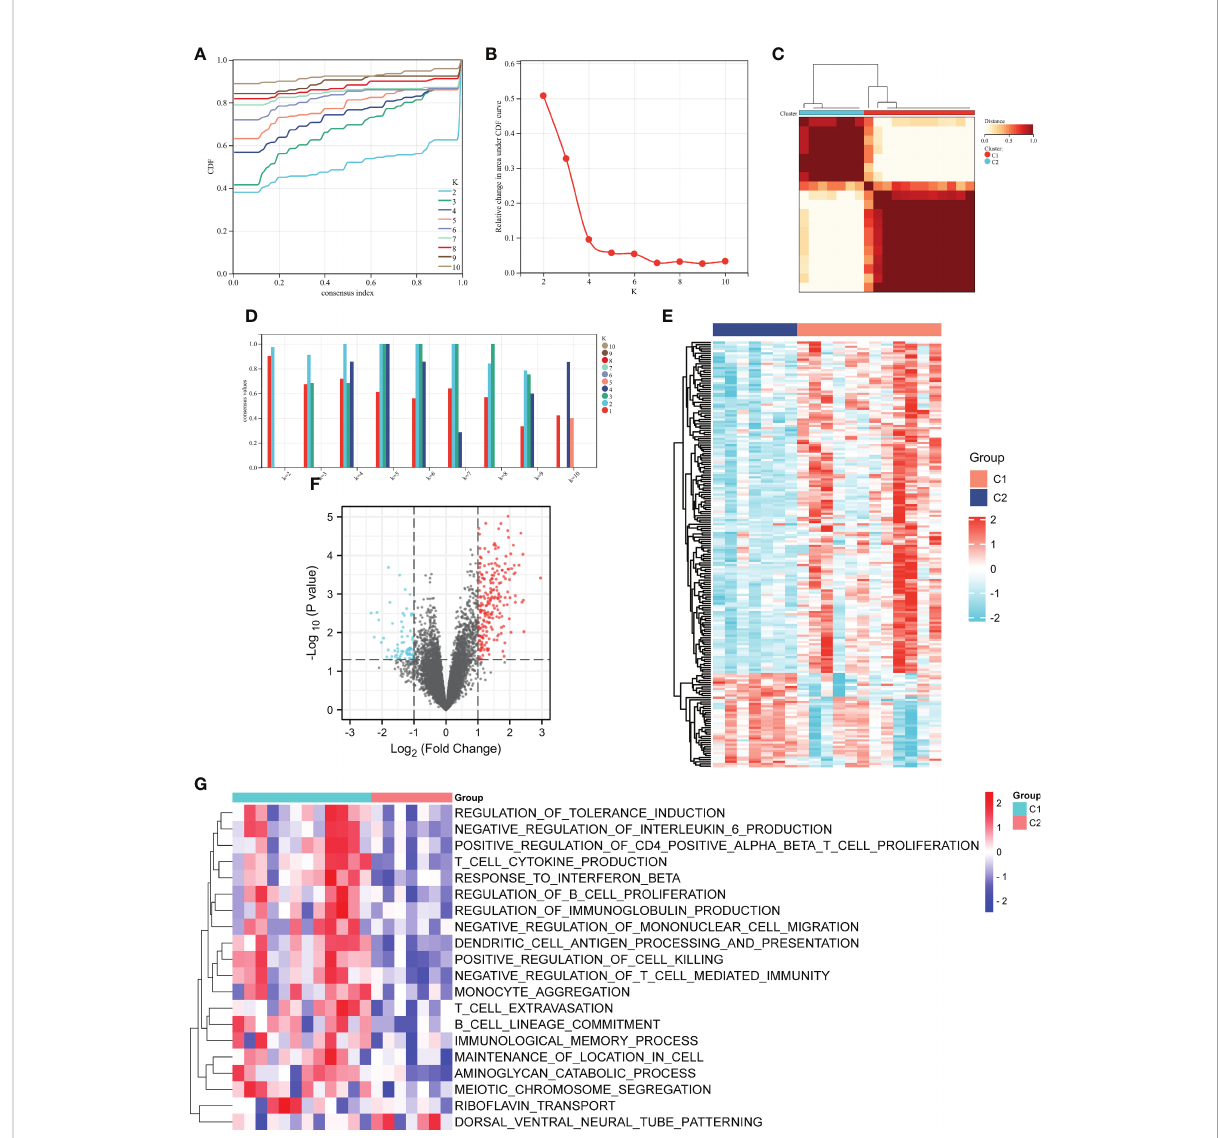
FIGURE 5 Unsupervised clustering analysis of immune-associated genes. (A) Consensus CDF when k = 2-10. (B) The cophenetic correlation coef fi cient was calculated for k = 2-10. (C) Consensus values when k = 2-10. (D) Heatmap of the matrix of co-occurrence proportions for DN samples. Heatmap (E) and volcano (F) and plots of the differential genes between C1 and C2 subgroups. (G) Heatmap of the potential pathways between C1 and C2 subgroups by GSVA. For the volcano, the blue dots indicated the down-regulated genes and the red dots indicated the up-regulated genes. For the heatmap, the down-regulated genes or pathways are presented in blue, and up-regulated genes or pathways are presented in